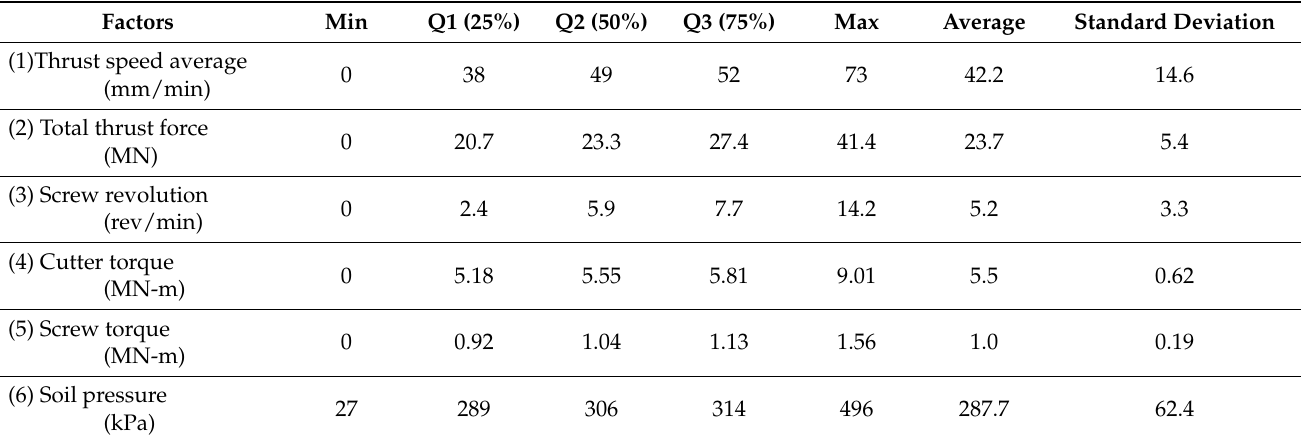
Table 4. Statistical description of the